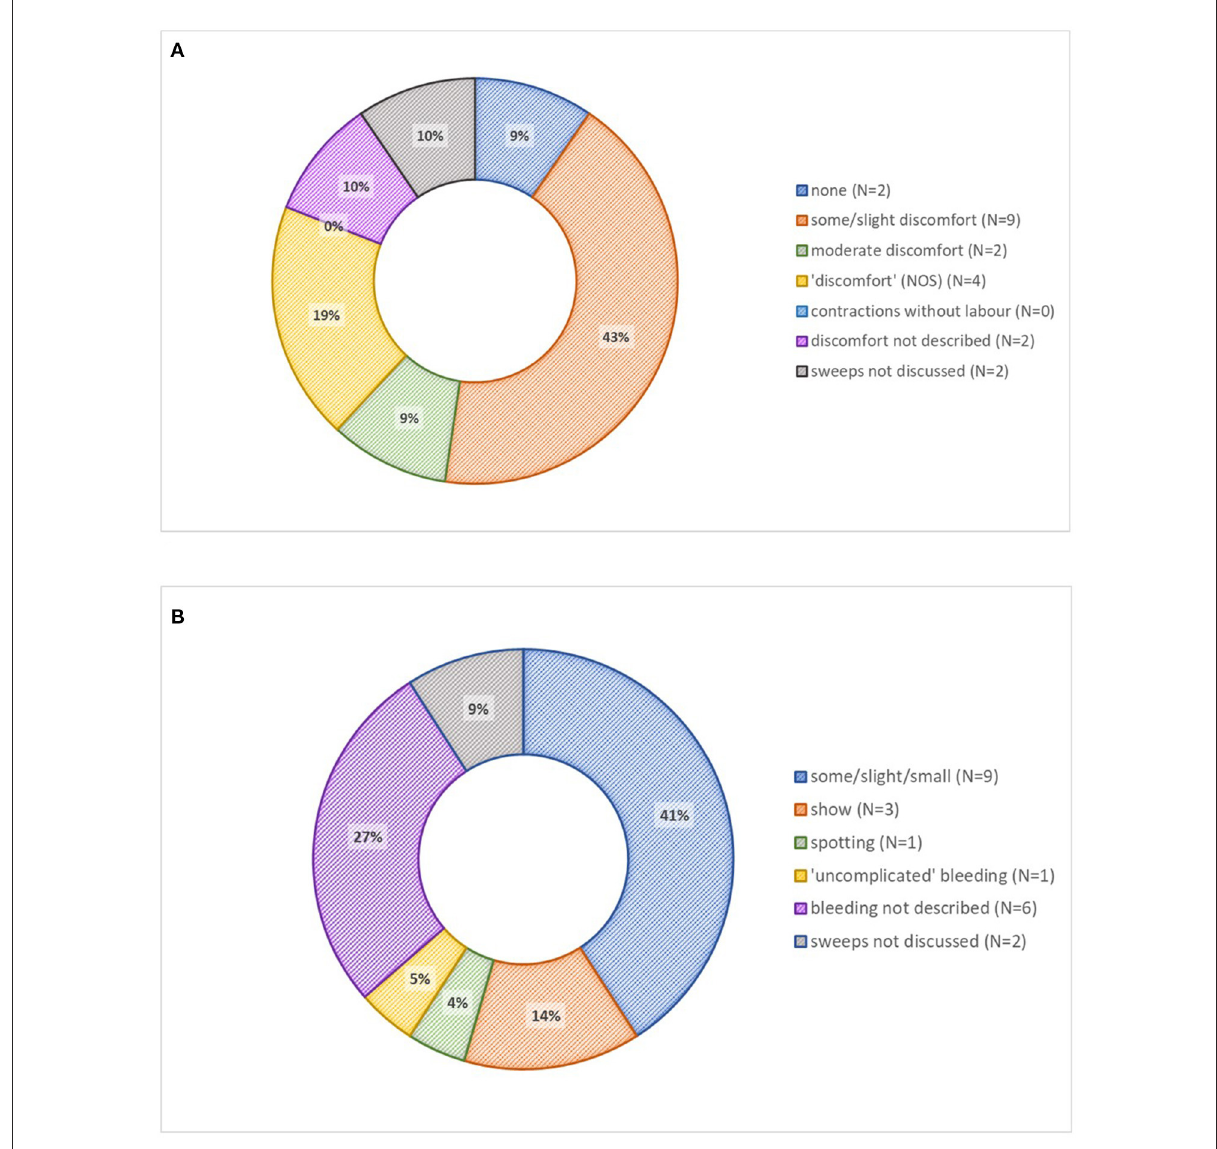
FIGURE2 Membrane sweeping descriptions in 21 patient information leaflets. (A) Discomfort associated with membrane sweeping. (B) Bleeding associated with membrane sweeping. IOL, induction of labor; NOS, not otherwise specified.